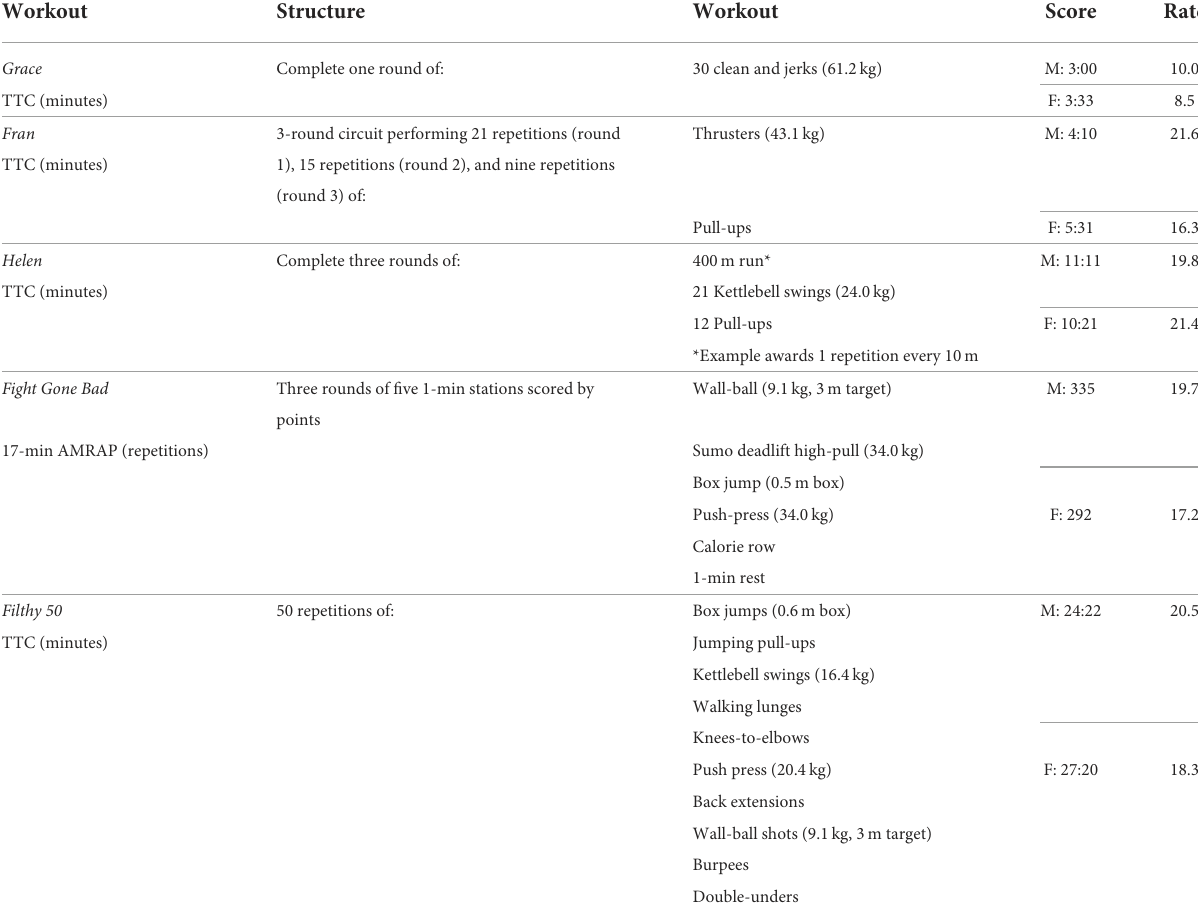
TABLE 1 Workout structure and average repetition completion rate for five benchmark workouts. Workout Structure